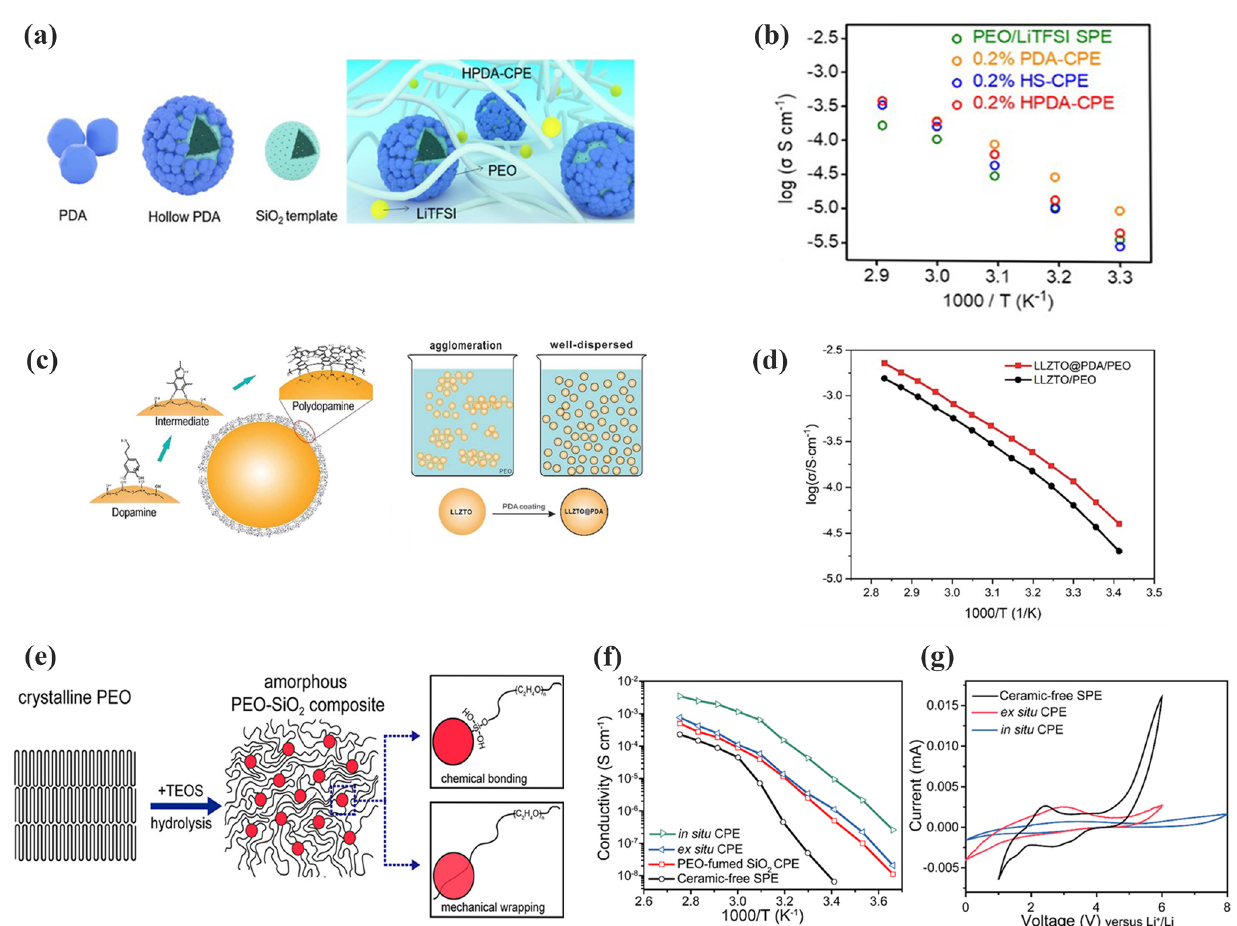
Fig. 2 a Schematic of HPDA-PEOCPEs; b Arrhenius plots for HPDA-PEO CPEs. Adapted with permission from Ref. [100]. c Schematic of 𝜎 ∼ dopamine on the surface of LLZTO particles; d Arrhenius log 1000/ T of LLZTO@PDA-PEO and LLZTO/PEO CPEs. Adapted with per- mission from Ref. [101]. e Schematic diagram illustrating the in situ hydrolysis process and the interaction mechanism between PEO chains and SiO 2 ; f Arrhenius plots of SiO 2 -PEO CPEs; g Electrochemical stability windows of SiO 2 -PEO CPEs. Adapted with permission from Ref.